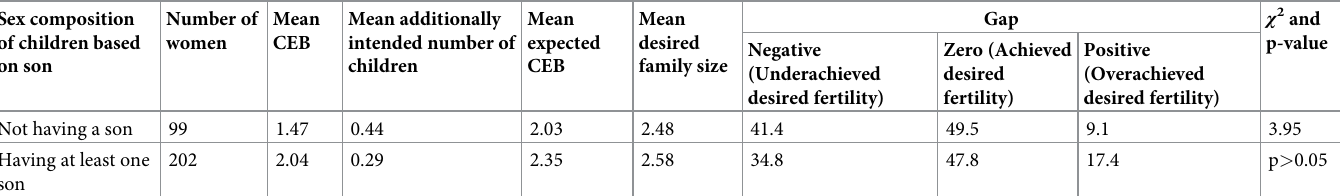
Table 4. Mean number of children ever born (CEB), mean expected CEB, mean desired family size and the gap between mean CEB and mean expected CEB by sex composition of children based on having or not having a son. Number of Sex composition of children based women on son